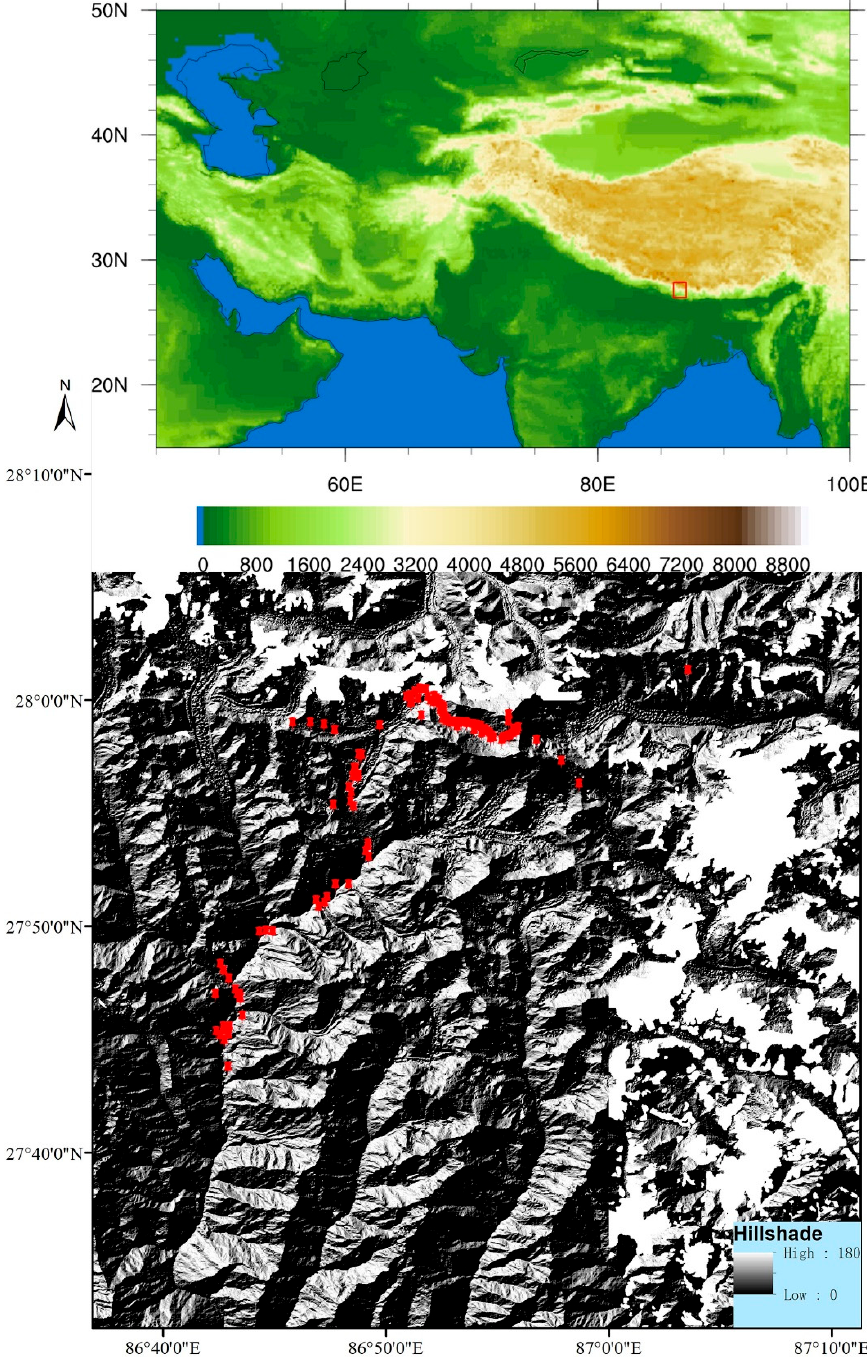
Figure 1. Map of meteoric- and surface-water-sampling sites in the Southern Himalaya. The red square in the upper panel indicate water-sampling area. The red markers in the lower panel demarcate surface-water-sampling sites against the hillslope background downloaded from Shuttle Radar Topography Mission (SRTM).